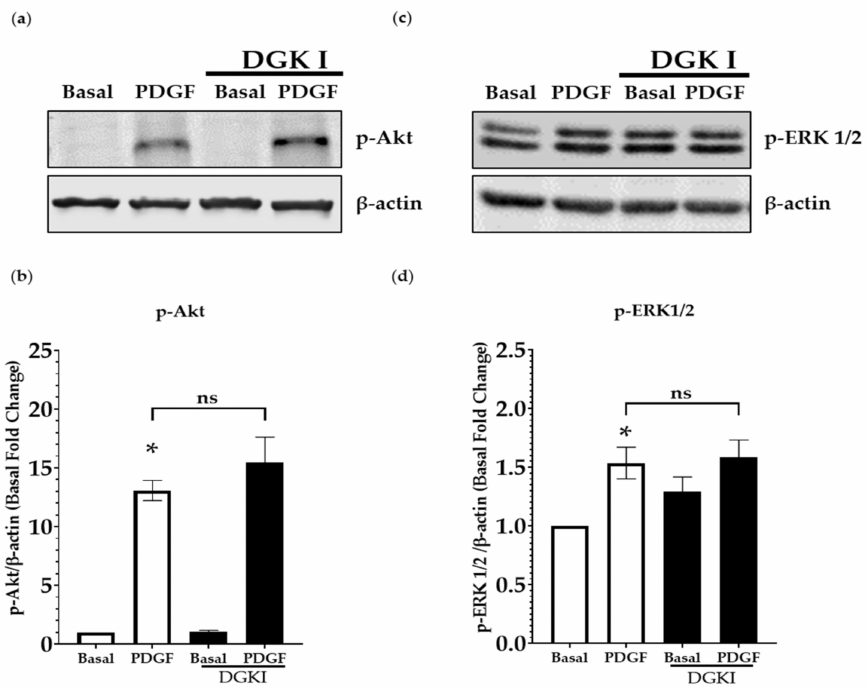
Figure 3. Effect of DGK inhibition on phosphorylation of Akt and ERK1/2. Human ASM cells were pretreated with DGKI (30 µ M) for 15 min followed by stimulation with PDGF (10 ng/mL) for 15 min. ( a , b ) Cells were lysed and immunoblotted for p-Akt and ( c , d ) p-ERK1/2. p-Akt and p-ERK1/2 densitometry are represented as fold change to basal conditions. Data above are mean ± SEM from n = 5–7 independent donors. * p < 0.05 Basal vs. PDGF using one-way ANOVA with Bonferroni post-hoc